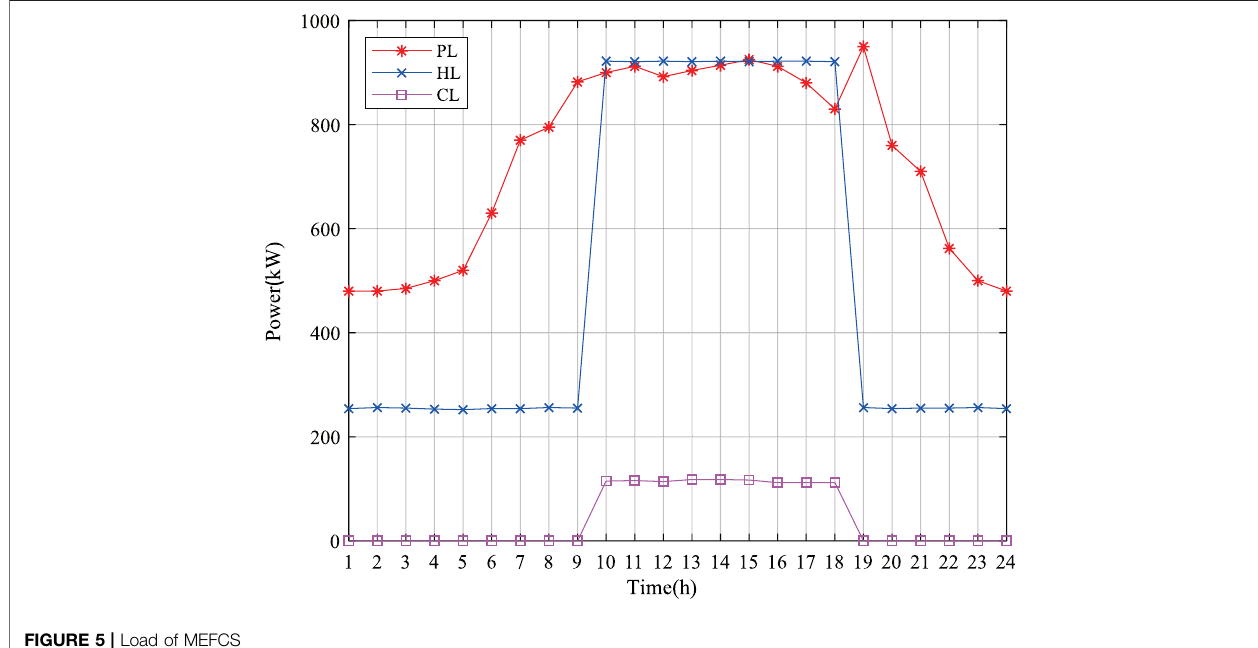
FIGURE 5 | Load of